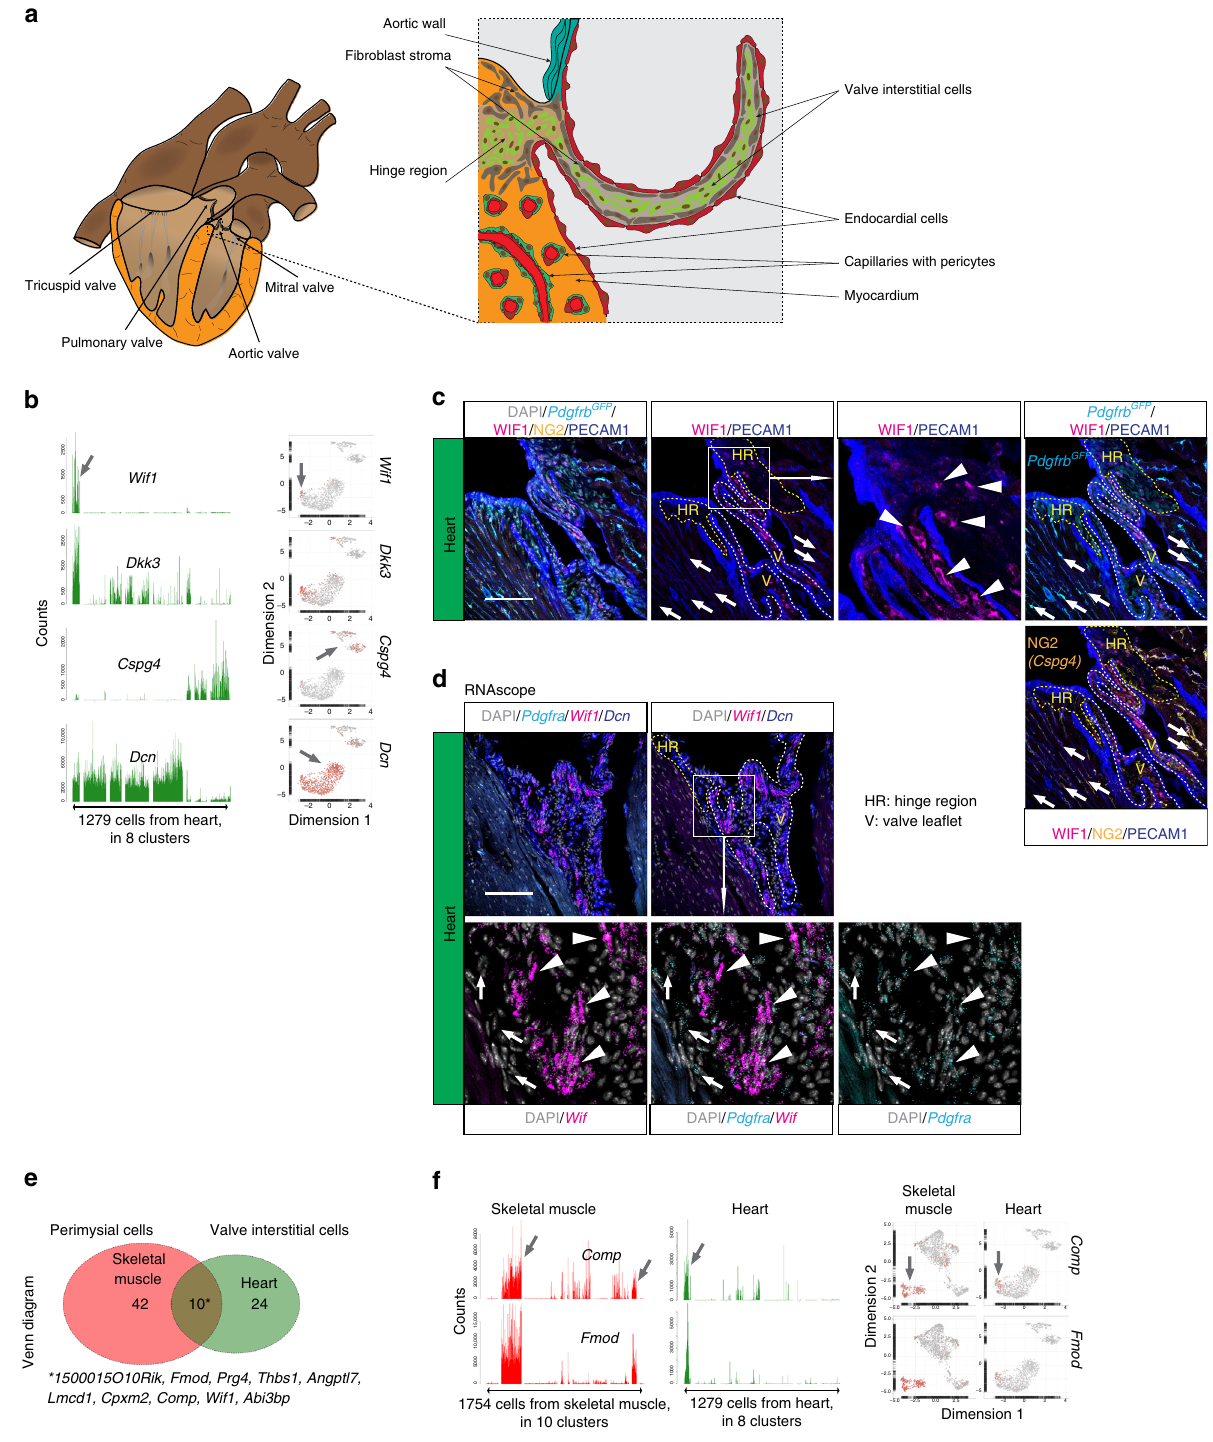
Fig. 4 Fibroblast subtypes of the heart. a Schematic depiction of heart anatomy. b Bar plots and UMAP visualization (gray, low; red, high expression) showing examples of cell subtype-speci fi c expression (arrow). c Immuno fl uorescence staining of heart from the Pdgfrb GFP reporter line for WIF1, NG2, and PECAM1, focused on the cardiac valve and hinge region. d RNAscope staining for Pdgfra , Wif1 , and Dcn , focused on the cardiac valve region. Arrowheads: valve interstitial cells; arrows: pericytes; HR: hinge region, V: valve lea fl et. Scale bar: 100 µ m. e Venn diagram showing skeletal muscle perimysial- and heart valve interstitial cell co-enriched genes. f Examples of co-enriched genes presented as bar plots and UMAP (gray, low; red, high expression). Asterisk: gene list of commonly enriched genes (see also Supplementary Table